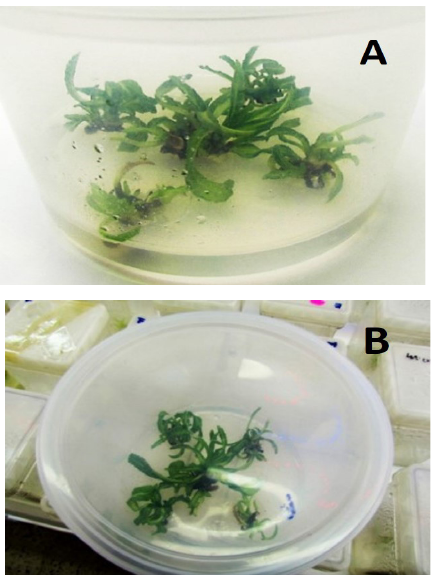
Figure 3. Artichoke microplants in multiplication medium: explants growing in container (A) and formation of lateral shoots (B).